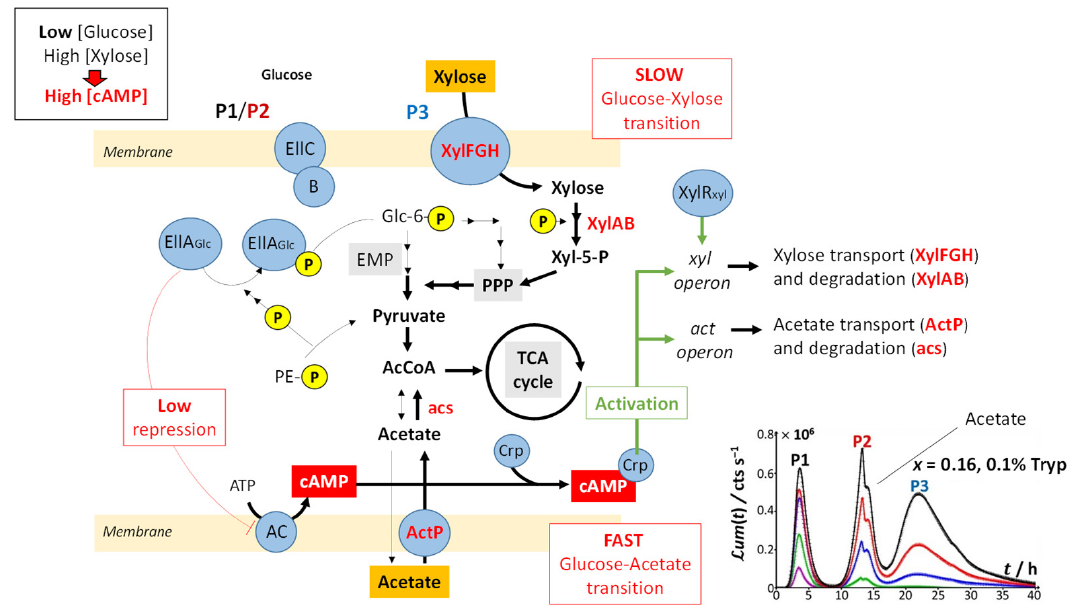
Figure 9. Schematic representation of the mechanisms underlying sugar degradation at sufficiently low glucose concentrations (low x ), which leads to the appearances of the P2 shoulder/P2 doublet and P3 peak. Under such x -conditions, glucose is transported into the cell and degraded to produce the energy required for light emission in modes 1 and 2 (P1 and P2, respectively), as detailed in Figure 8. In parallel, acetate originating from glucose breakdown is expelled from the cell. A low glucose concentration leads to a lower amount of non-phosphorylated EIIA proteins and thus to a lower inhibition of adenylate cyclase. The concentration level of cAMP thus increases, which allows for the formation of the cAMP/Crp complex and the activation of the simultaneous transcriptions of the acetate and xylose operons (albeit at different rates) necessary for their intracellular transport and degradation. Abbreviations: PE-P, phosphoenolpyruvate Glc-6P; Glucose 6-phosphate; EMP, Embden–Meyerhof–Parnas pathway; PPP, the pentose phosphate pathway; AcCoA, acetyl CoA; TCA cycle, tricarboxylic acid cycle; AC, adenylate cyclase; ATP, adenosine triphosphate; cAMP, cyclic adenosine monophosphate; Crp, cAMP receptor protein; ActP, cation/acetate symporter. The inset displays the time-dependent luminescence response corresponding to the molecular mechanisms highlighted in the scheme, with the P2 shoulder originating from the acetate that is metabolized by cells.